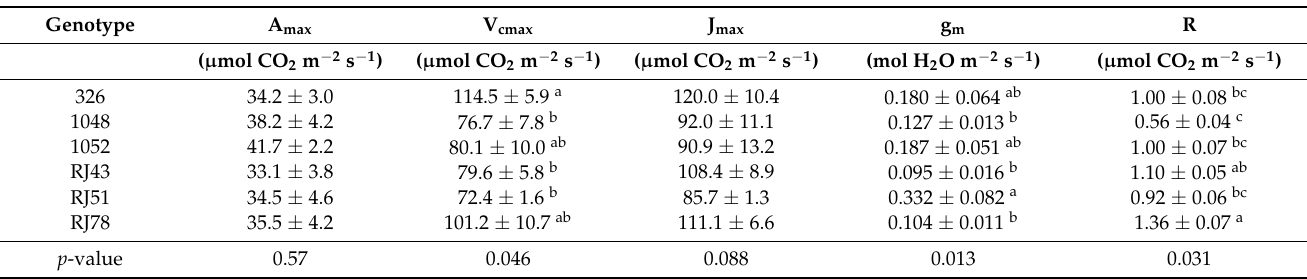
Table 4. Average photosynthetic traits derived from A N /C i curves for each genotype; maximal photosynthesis (A max ), maximal carboxylation velocity (V cmax ), maximal electron transport rate (J), mesophyll conductance (g m ) and leaf respiration (R). Lower case letters indicate differences between means (Tukeys tests, p <0.05).